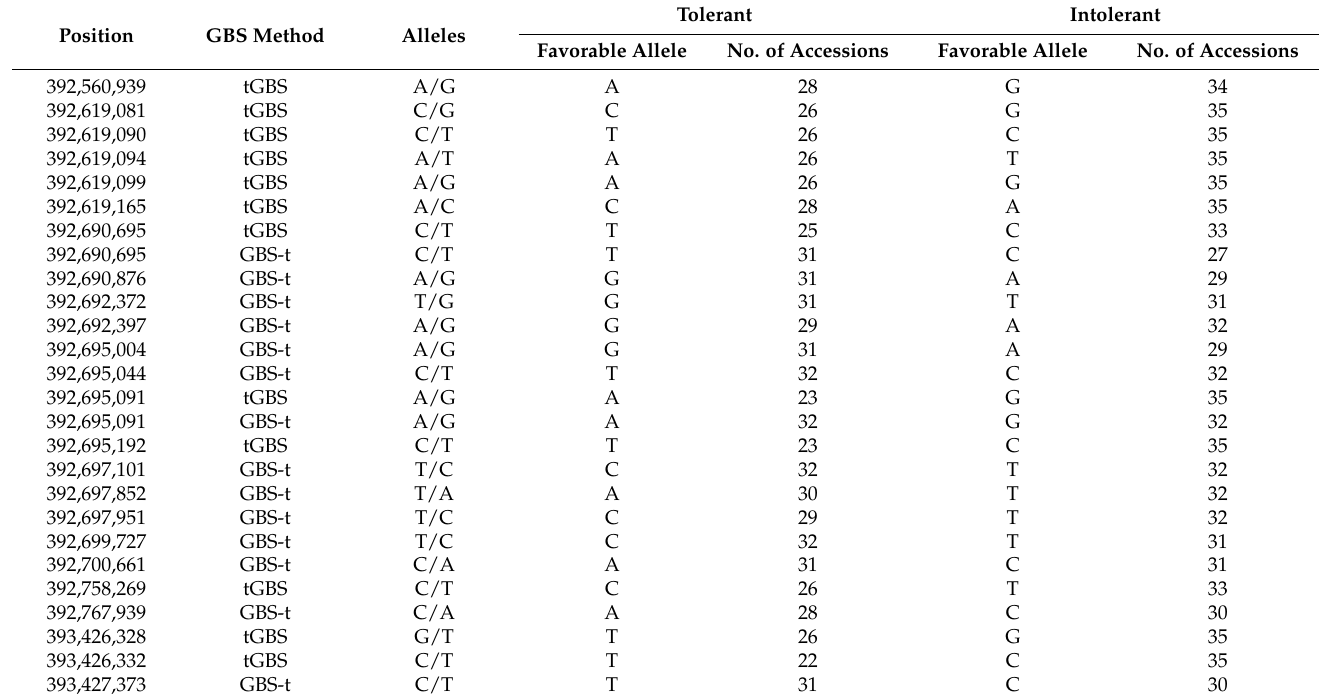
Table 2. Favorable alleles observed in significant SNP positions ( − log 10 p -value ≥ 5) on Chromosome 2 for phenotypic scores, using two GBS